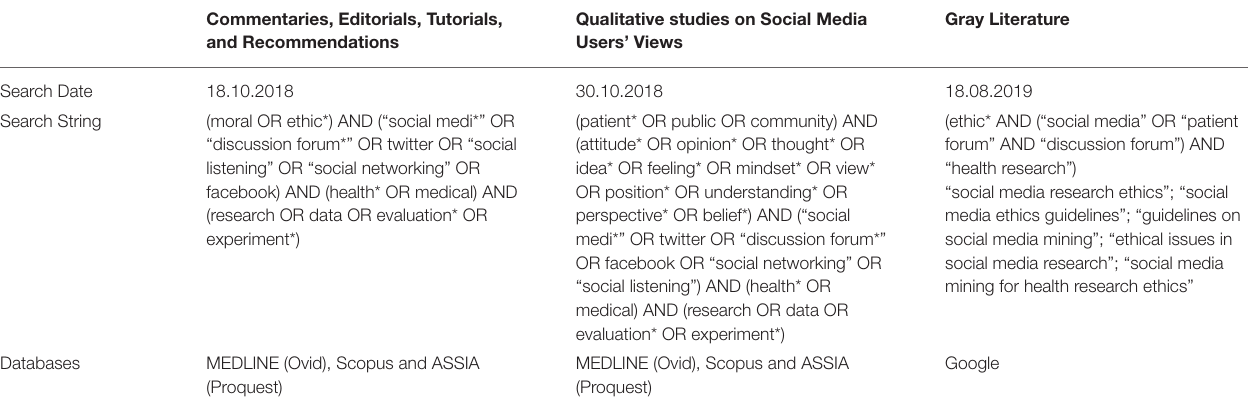
TABLE 1 | Search date, search strings, and databases for three